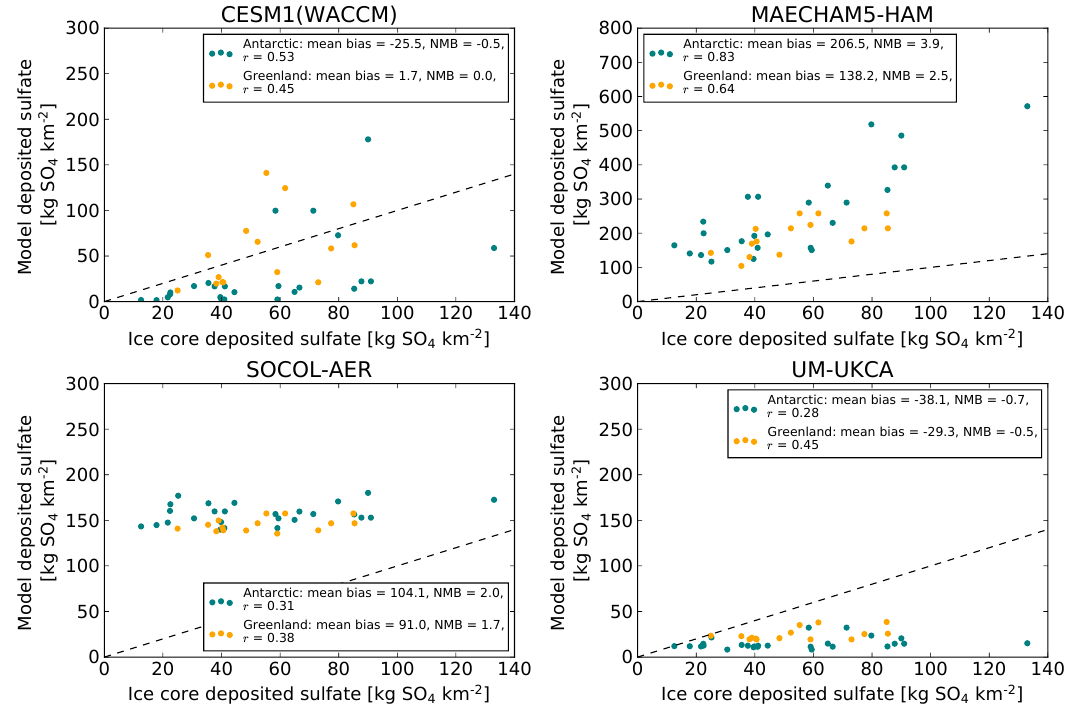
Figure 7. Scatter plots of cumulative deposited sulfate (kgSO 4 km − 2 ) due to the eruption of Mt. Tambora recorded in ice cores vs. that simulated by each model (ensemble mean) in Antarctica (teal points) and Greenland (orange points). Simulated values represent the grid box value where each ice core is located. The dashed line marks the 1 : 1 line. For each model and for Greenland and Antarctica the mean bias, normalized mean bias (NMB) and correlation coefficient ( r ) between the simulated deposited sulfate and ice core values are shown in the legend. There is an increased y -axis scale for